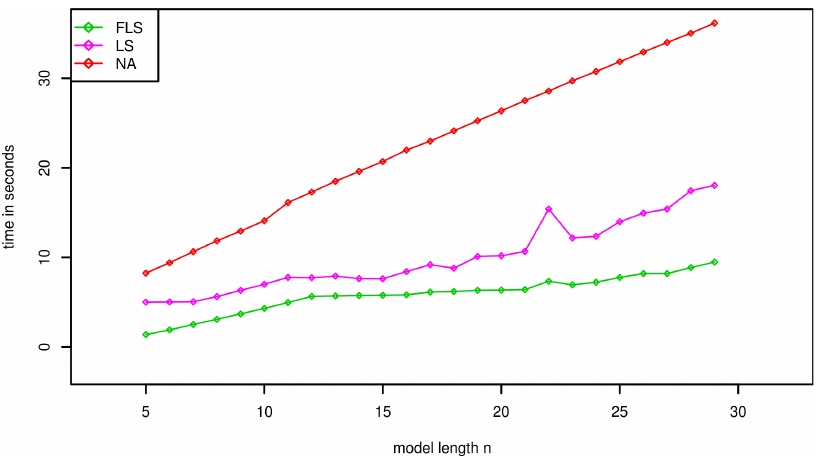
Fig 3. Average running times (in Seconds, Preprocessing excluded) of different algorithms for model MOD2 with p-value γ = 0.0001.